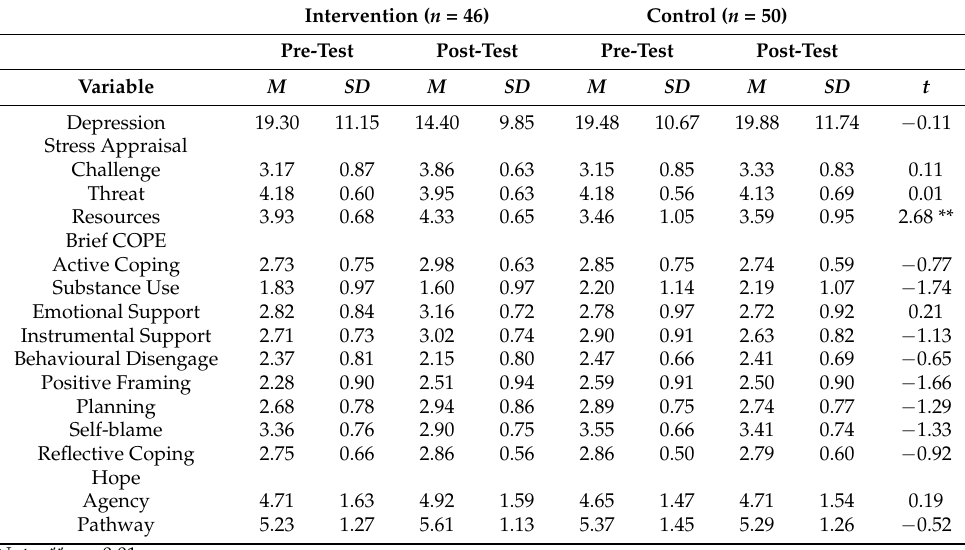
Table 3. Descriptive statistics and baseline comparisons ( n = 96).